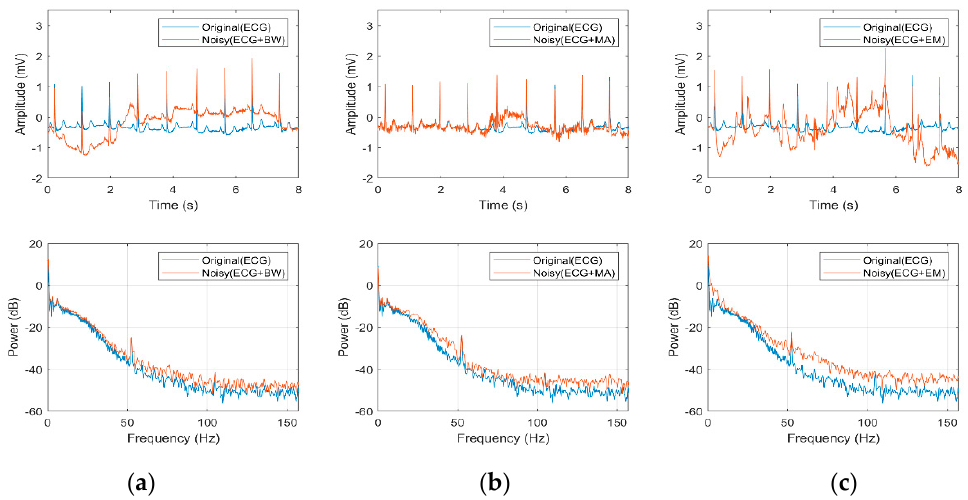
Figure 1. Eight-seconds of clean and noisy electrocardiogram (ECG) signals at a sampling rate of 360 Hz: ( a ) ECG with baseline wander (BW); ( b ) ECG with muscle artefact (MA); ( c ) ECG with electrode motion (EM) artefact.